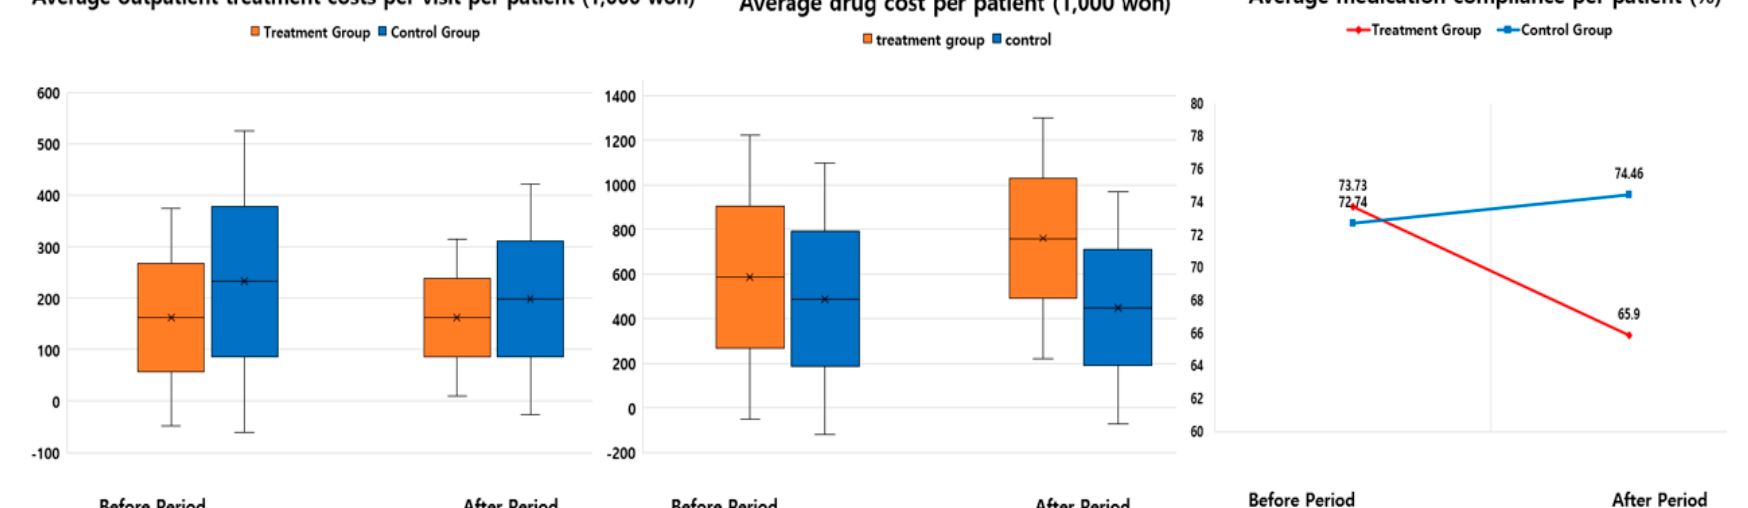
Figure 3. Outcomes of interest regarding strength of healthcare service utilization.